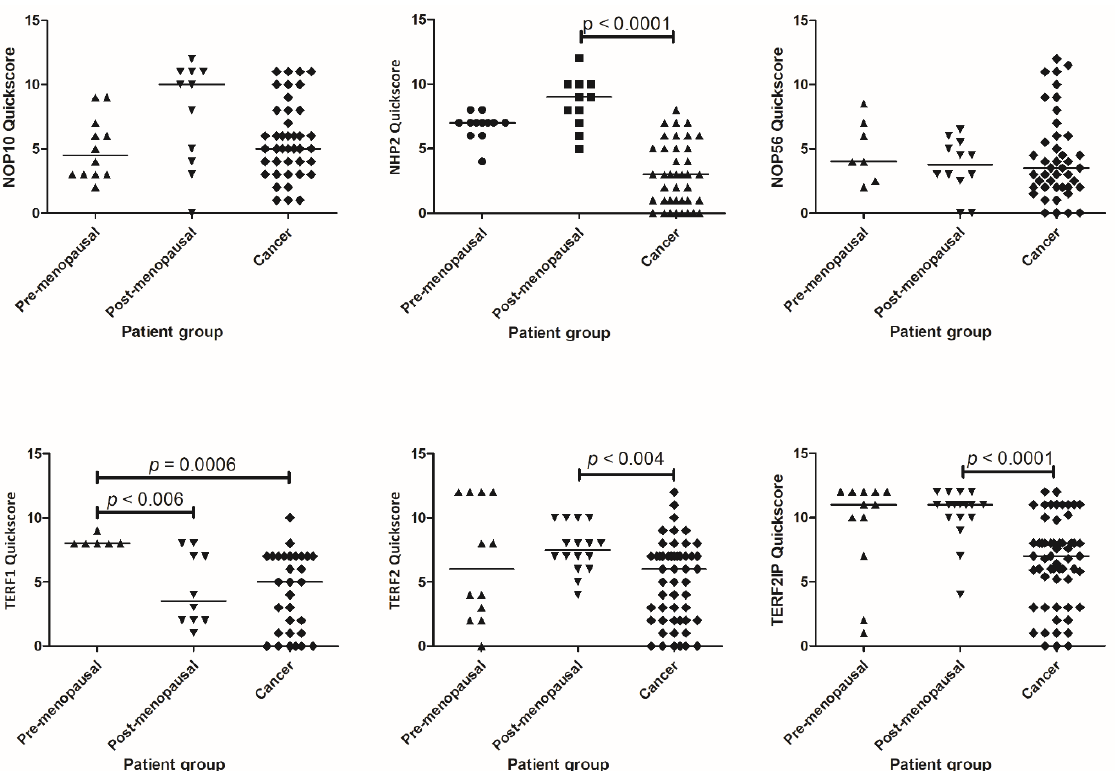
Figure 3. Scatterplots to show Quickscores for NOP10, NHP2, NOP56, TERF1, TERF2 and TERF2IP. Line indicates median. NOP10 pre-menopausal n = 12, post-menopausal n = 11 (pre-menopausal vs. postmenopausal p = 0.059), cancer n = 39; NHP2 pre-menopausal n = 12, post-menopausal n = 11, cancer n = 41; NOP56 pre-menopausal n = 7, post-menopausal n = 12, cancer n = 43; TERF1 pre-menopausal n = 6, post-menopausal n = 10, cancer n = 30; TERF2 pre-menopausal n = 12, post-menopausal n = 16, cancer n = 51; TERF2IP pre-menopausal n = 12, post-menopausal n = 17, cancer n = 57.